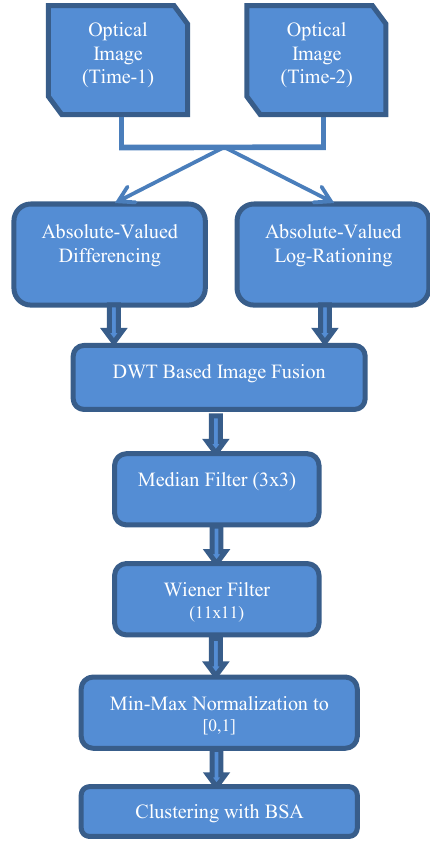
Figure 1. General scheme of proposed